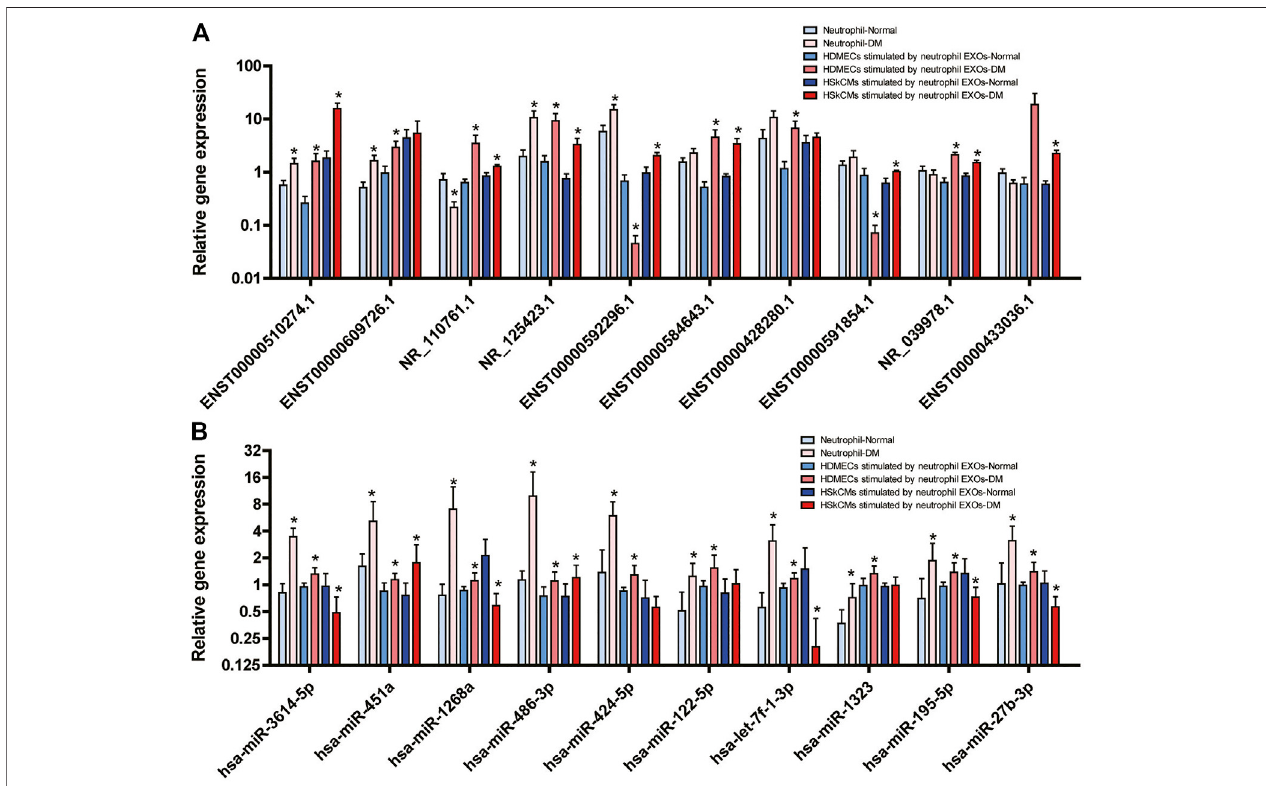
FIGURE 1 | Expression levels of DE lncRNAs (A) and DE miRNAs (B) in the PI3K – Akt, MAPK, AMPK and FoxO signalling pathways validated by real-time quantitative PCR in neutrophils of DM patients and in HDMECs and HSkMCs after stimulation with DM neutrophil EXOs (*DM vs. NC).